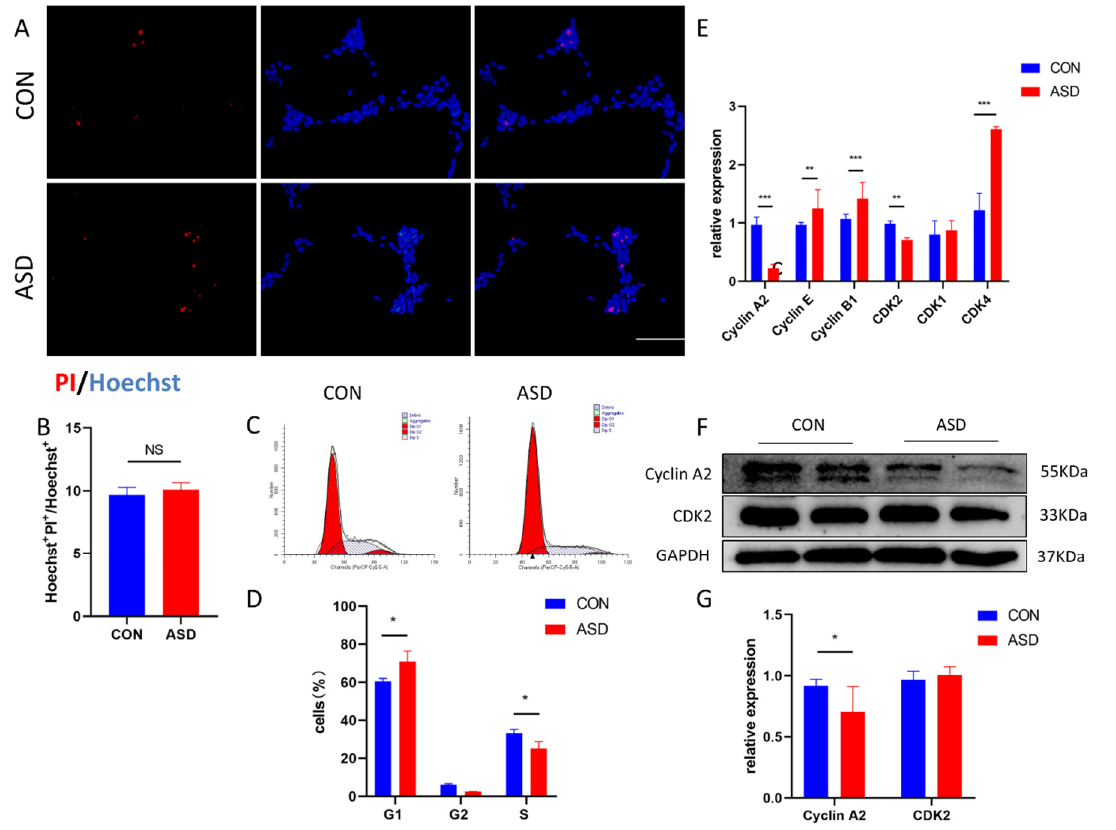
Figure 2. Abnormal cell cycle of ASD-NPCs, with no difference in apoptosis. ( A , B ) CON and ASD-NPCs were stained with Hoechst (blue) and PI (red). The percentage of PI-labeled cells was calculated. ( C , D ) FCM analyses of the cell cycle of NPCs showing the percentages of cells at different cell cycle phases. ( E – G ) Relative expression of cell cycle-related genes of CON and ASD-NPCs as determined by RT-qPCR and western blot. All data represent mean ± SEM; scale bar: 100 µm; *** p < 0.001, ** p < 0.01, * p < 0.05.